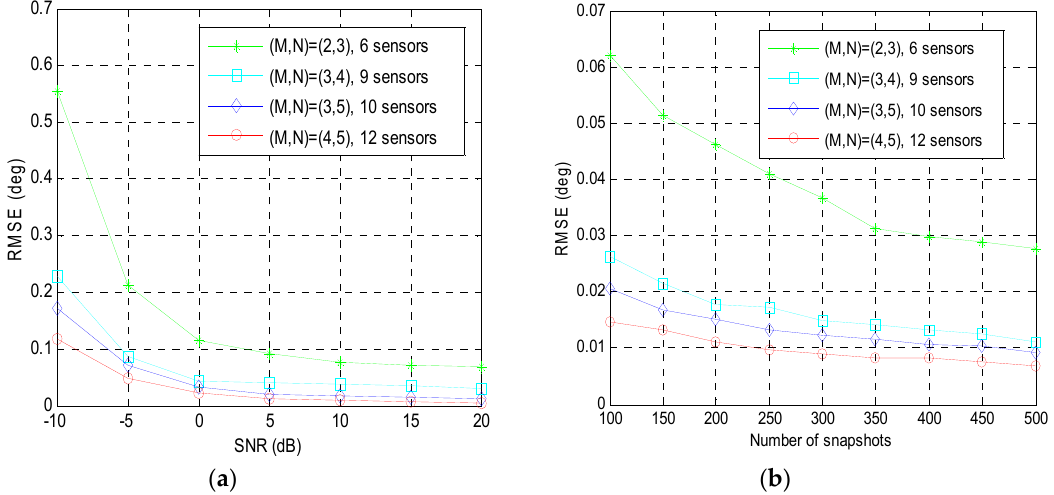
Figure 6. The RMSE performance of the proposed method in different coprime array configurations: ( a ) RMSE versus the input SNR; ( b ) RMSE versus the number of snapshots; fifth example.